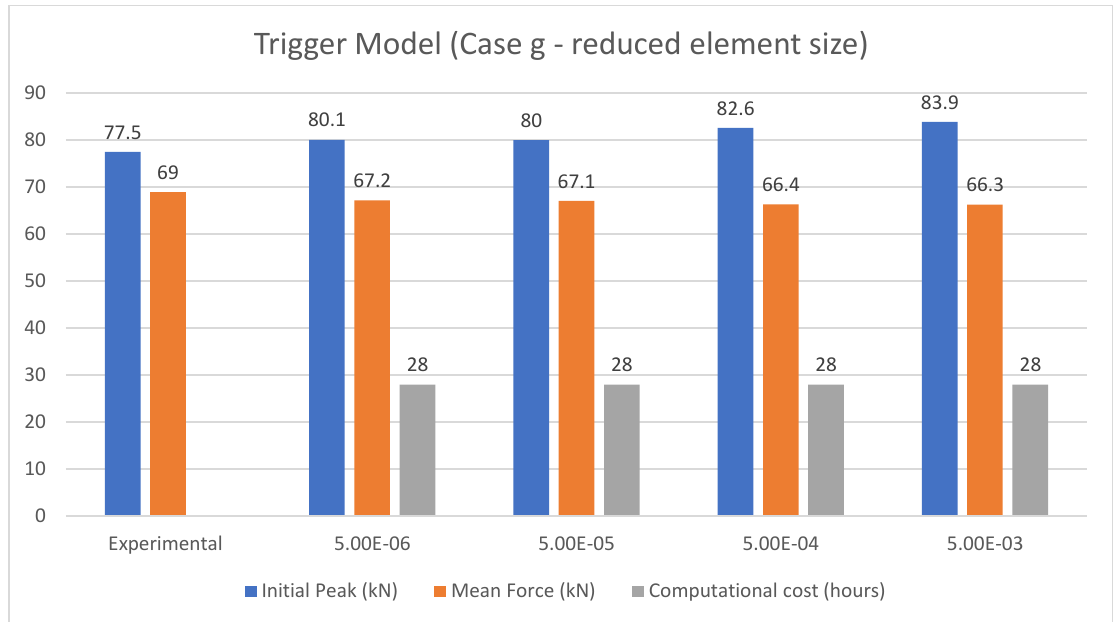
Figure 10. Trigger model case (g) comparison [66].